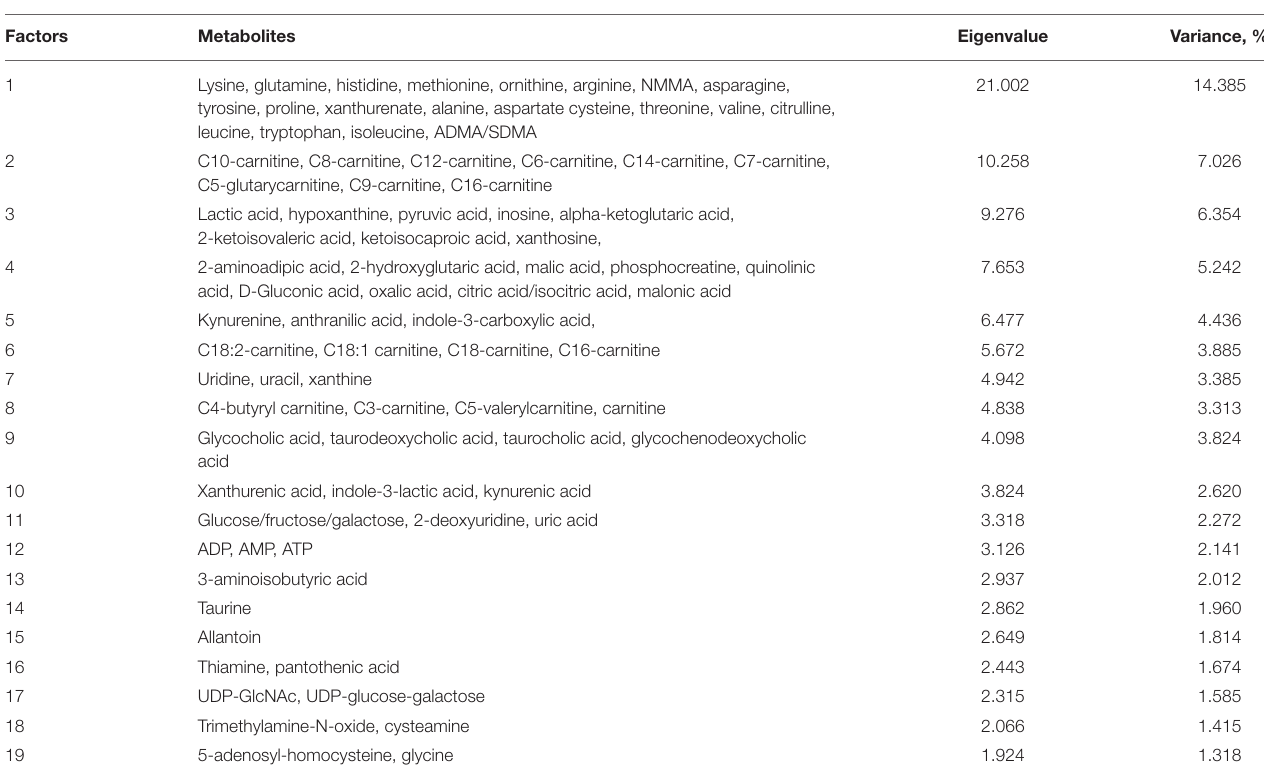
TABLE 2 | Principal Component Analysis Factors.